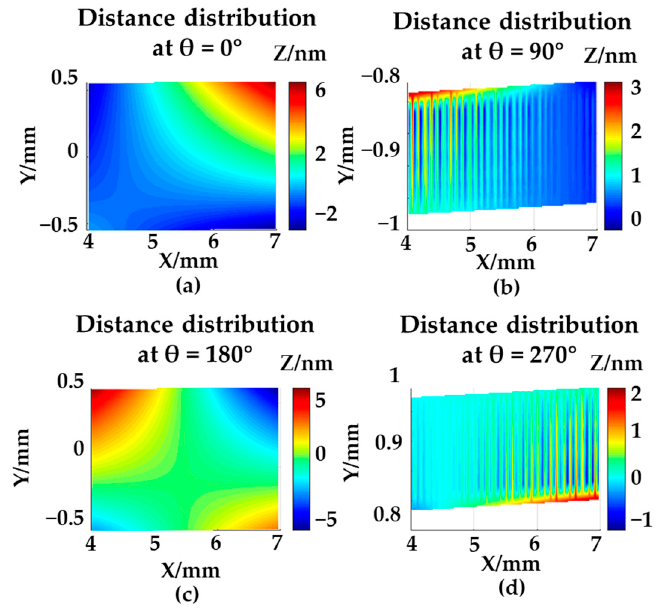
Figure 7. The distance distribution in the XOY plane after rotary-axis compensation in simulation: ( a ) θ = 0°; ( b ) θ = 90°; ( c ) θ = 180°; ( d ) θ = 270°.